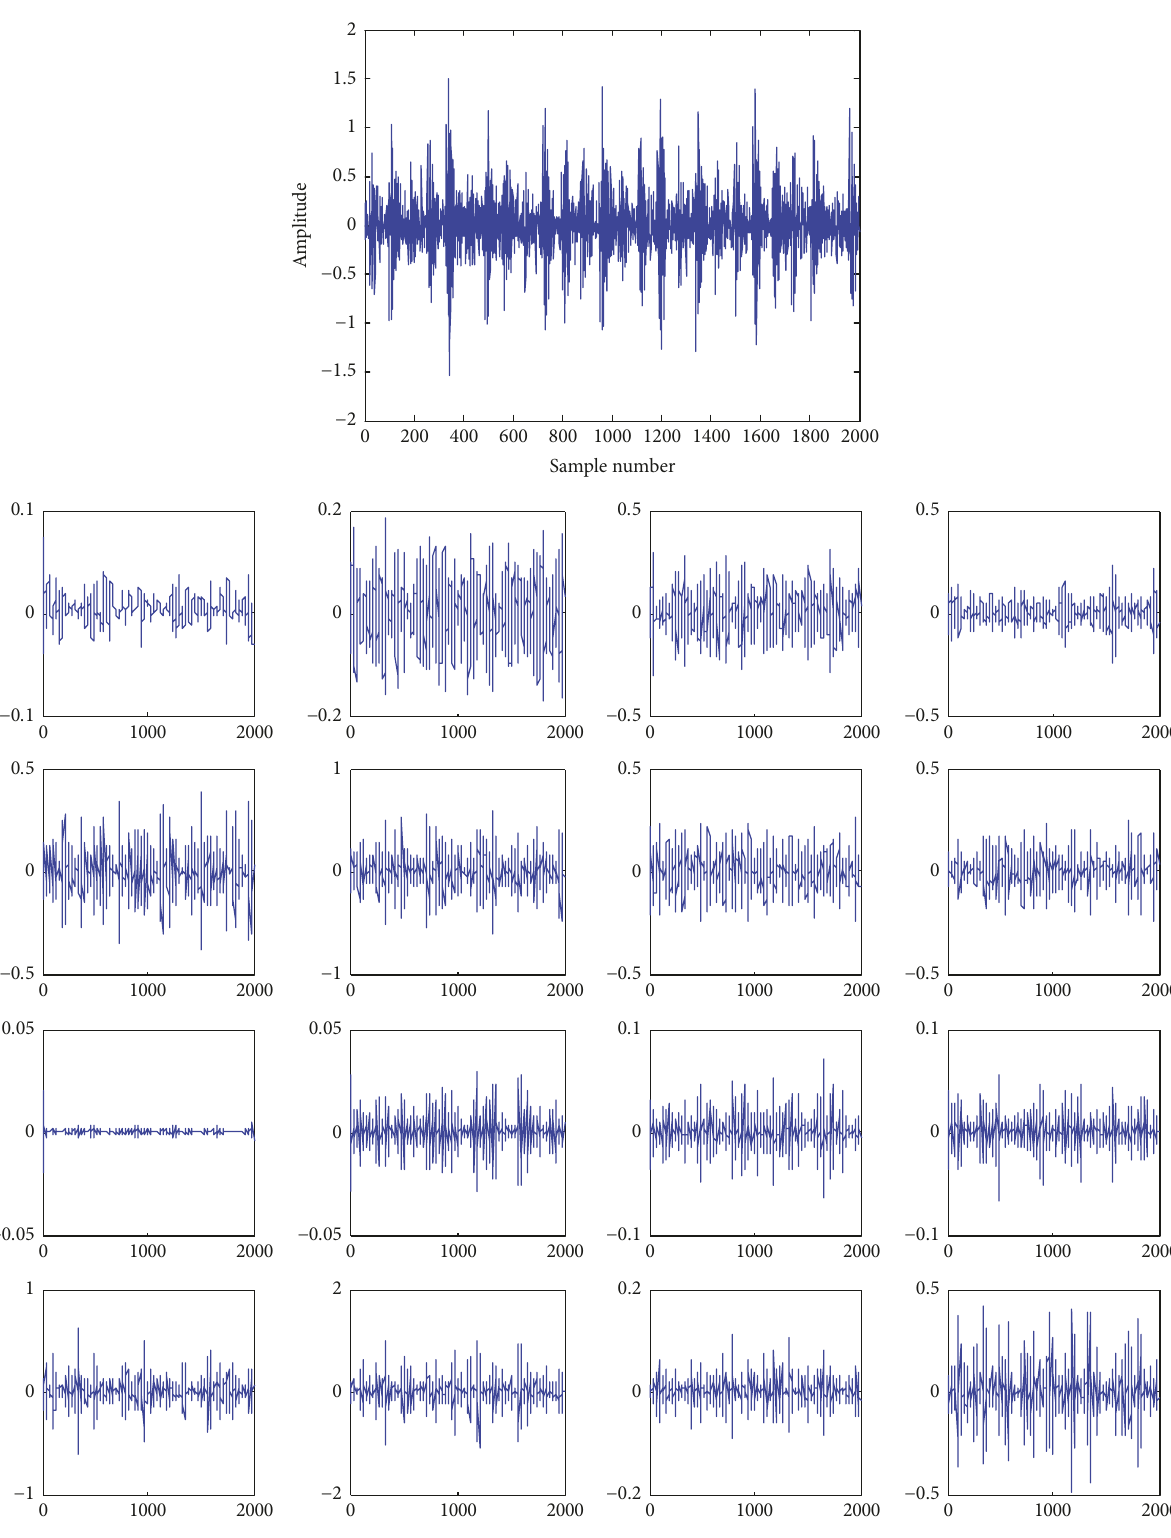
Figure 4: A vibration signal sample and the corresponding single branch reconstruction signals of terminal